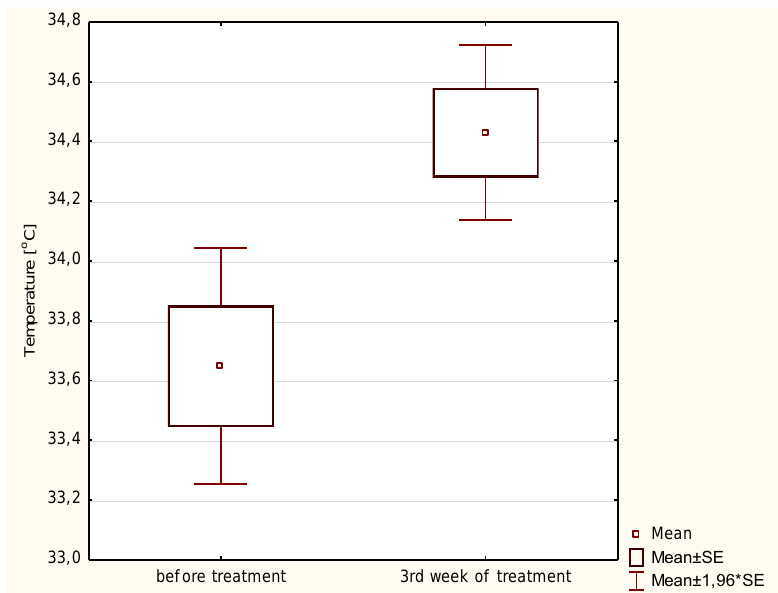
Figure 3. Average temperature of patients in the PTV area before and after 3 weeks of radiotherapy. Measurements of the temperature distribution before radiotherapy and in each treatment week were verified in the target area, where 30 Gy, 20 Gy and 10 Gy isodoses were applied.